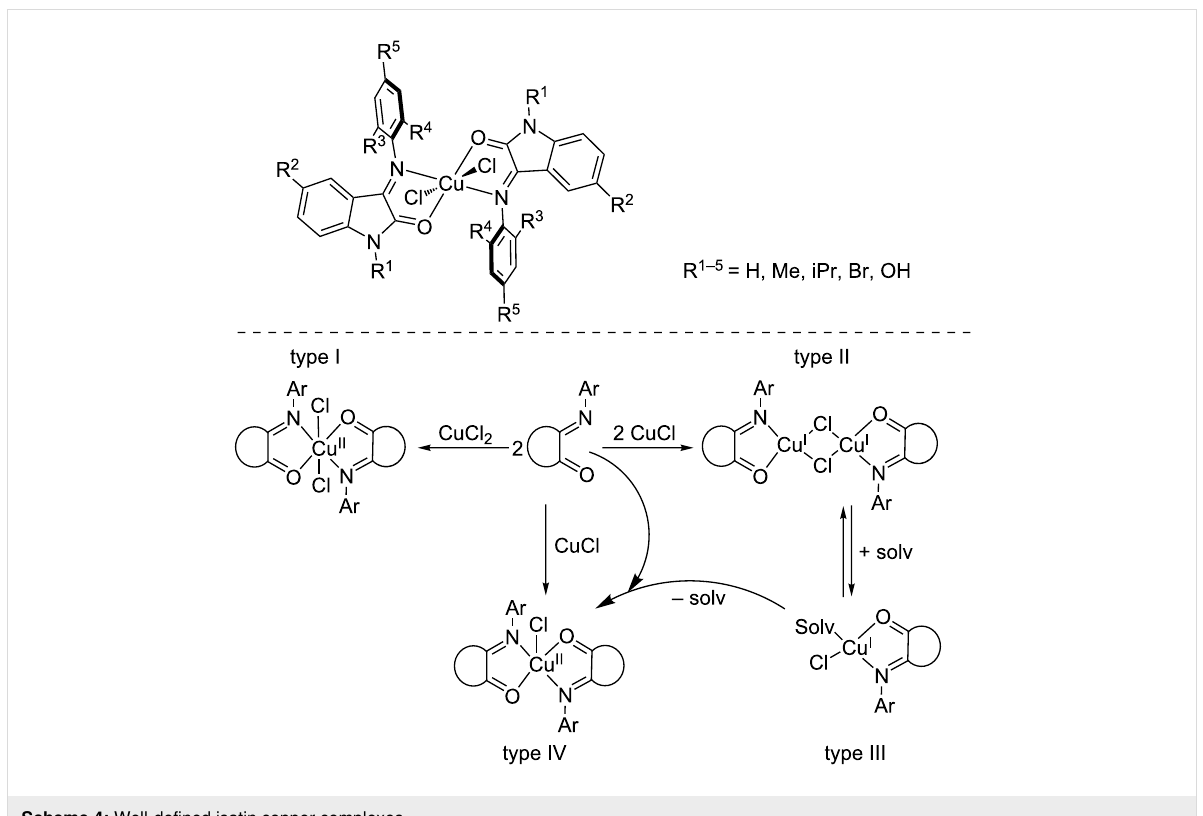
Scheme 4: Well-defined isatin copper